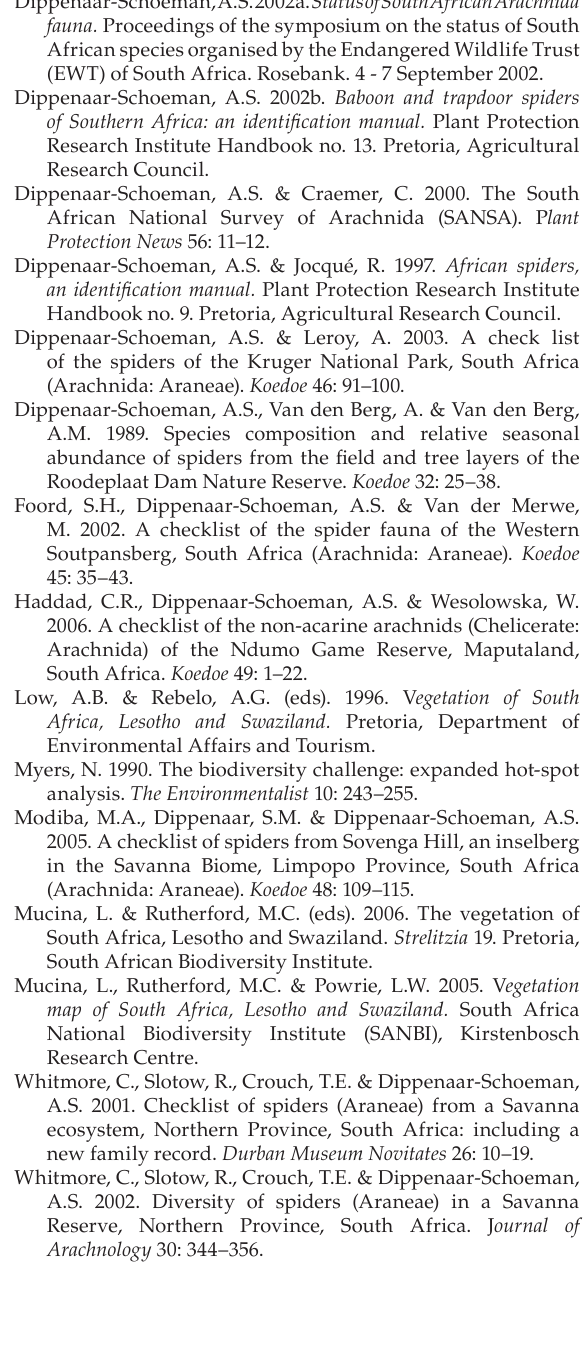
Province. only one of the previously recorded species (i.e. Augacephalus junodi (Simon, 1904)) was encountered